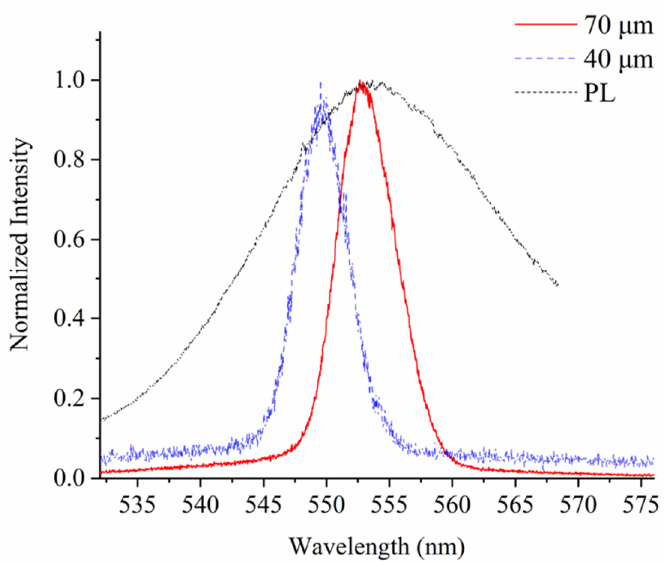
Figure 6. Structure dependent narrow emission. The FWHMs reduce to 5.5 nm (in red) and 4.9 nm (in blue) for the 70 μm and 40 μm sample, respectively, at high pump power exceeding 7.2 μW, indicating good film morphology for the ring optical structure emission enhancements. PL spectrum (in black) was recorded by pumping a sample below threshold without Nd additives.